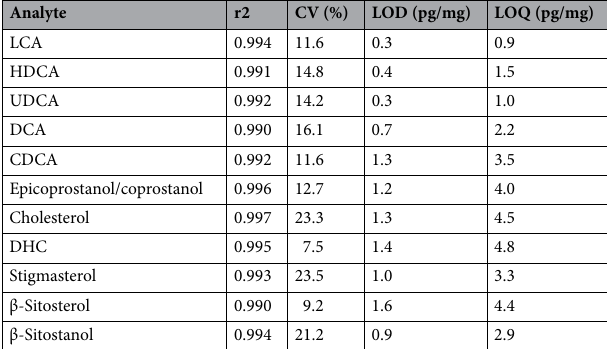
Table 3. Validation